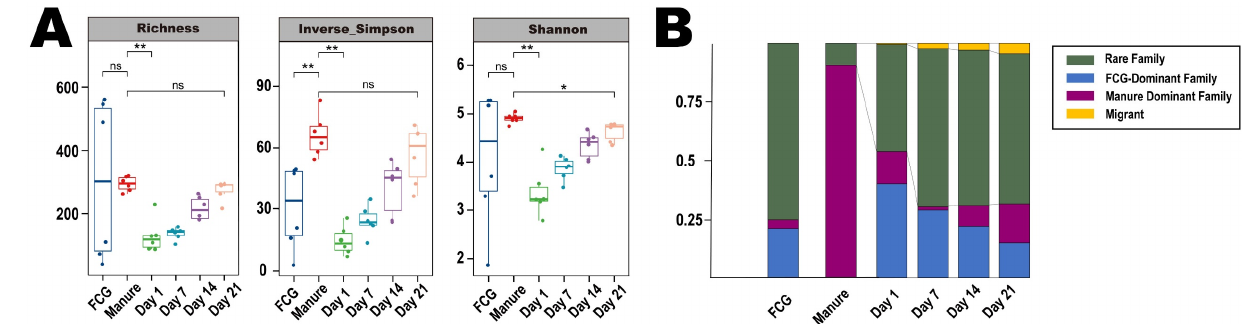
Figure 4. The alteration of alpha diversity and bacterial family composition. ( A ) Richness, inverse Simpson, and Shannon diversities were calculated and compared using boxplots. The components of comparisons are fermented coffee grounds (FCG), manure, and days 1, 7, 14, and 21 after treatment. The Wilcoxon signed-rank test was applied to monitor the difference in alpha diversity of FCG and manure as well as the decrease in diversity after one day of the treatment and to manifest the recovery of diversity at the endpoint of the experiment (21 days after treatment). ns (nonsignificant) p > 0.05, * p < 0.05, ** p < 0.01. ( B ) Whole bacterial families were categorized by prevalence in FCG and cow manure samples as FCG-dominant, manure-dominant, rare, and migrant. The shifts of families associated with each group are represented as relative abundance.